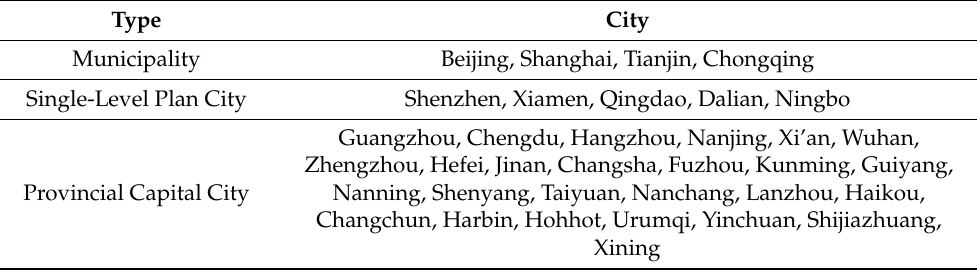
Table 1. The selected 35 major cities in